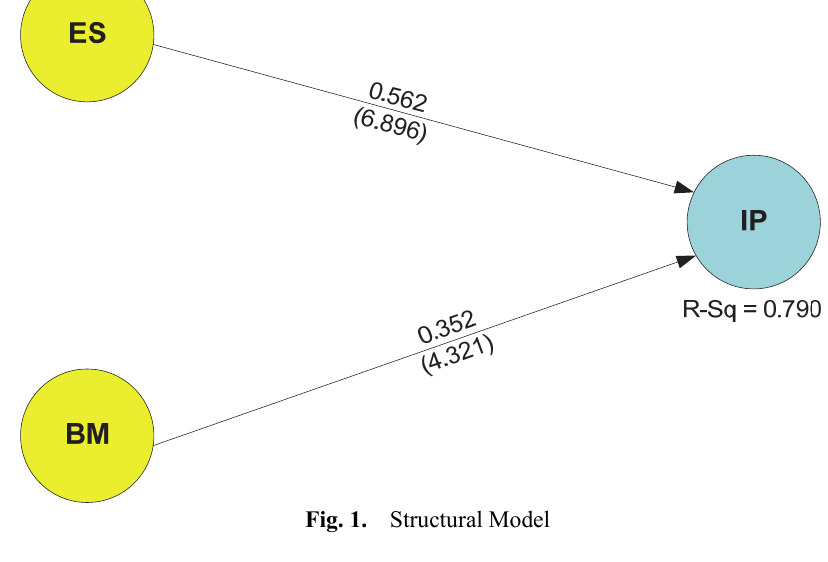
Fig. 1. Structural